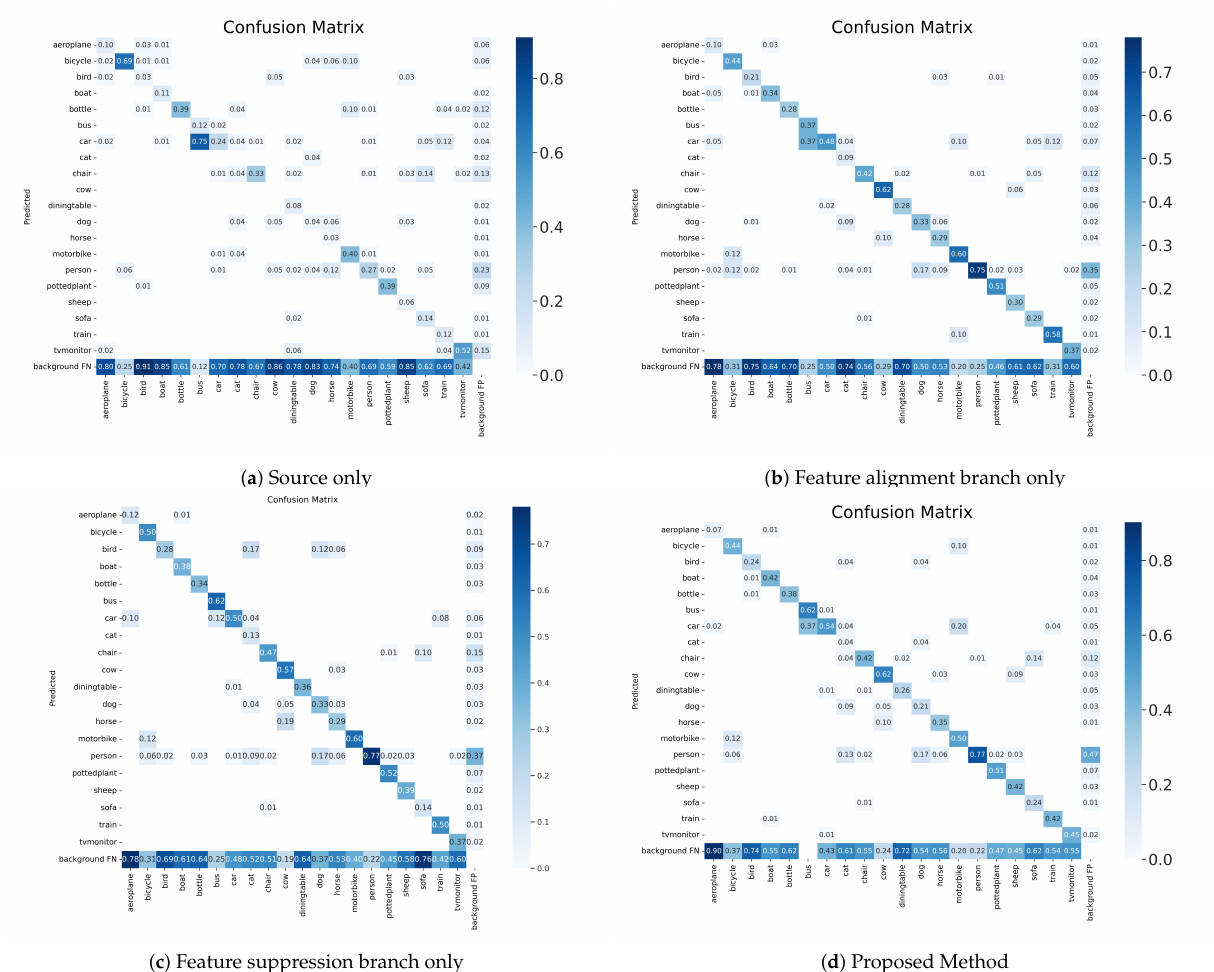
Figure 6. Confusion matrix on Pascal VOC → Clipart transfer.